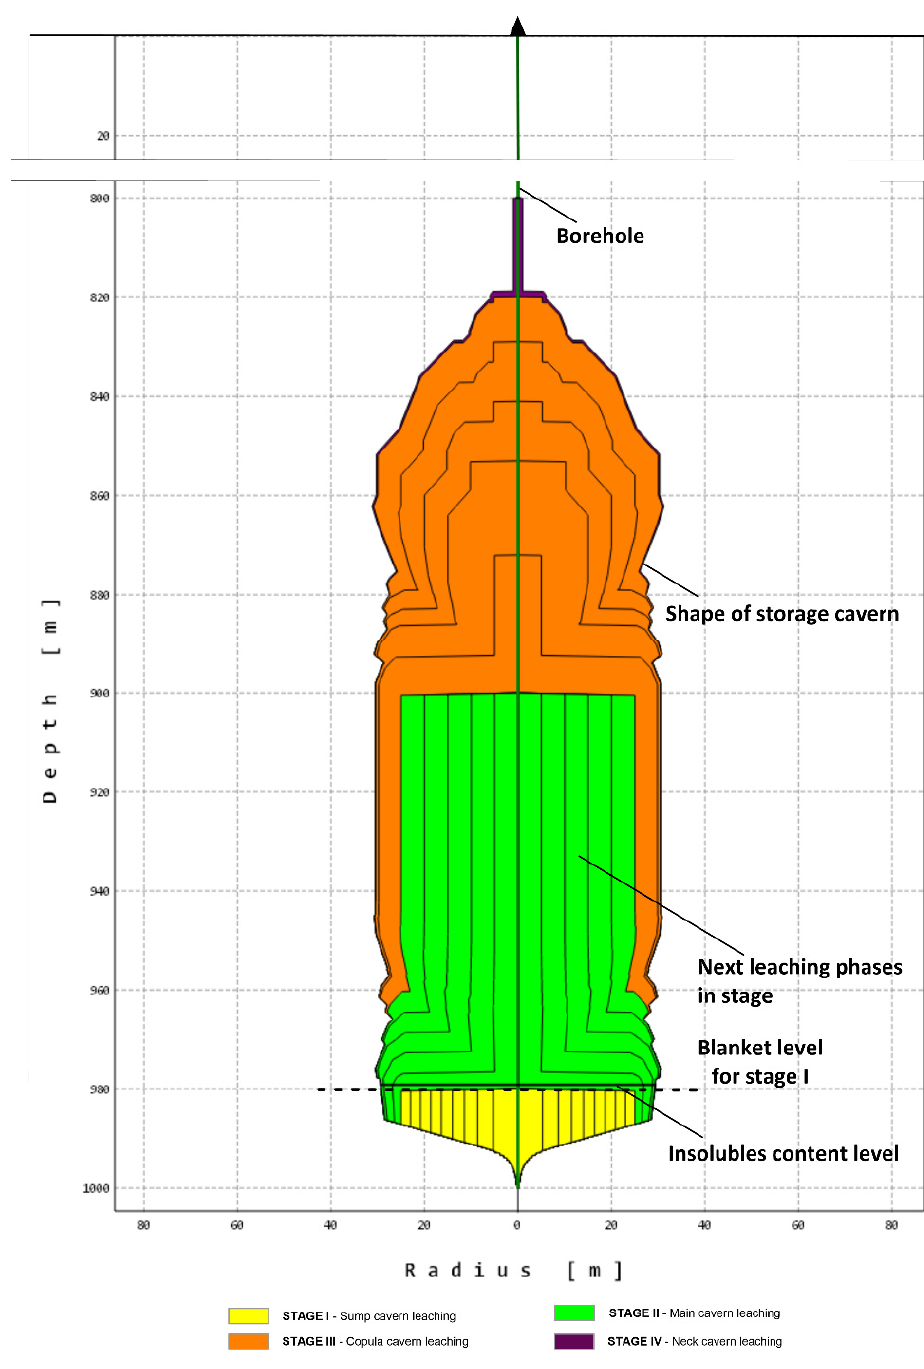
Figure 2. Stages and phases of classic storage cavern leaching.